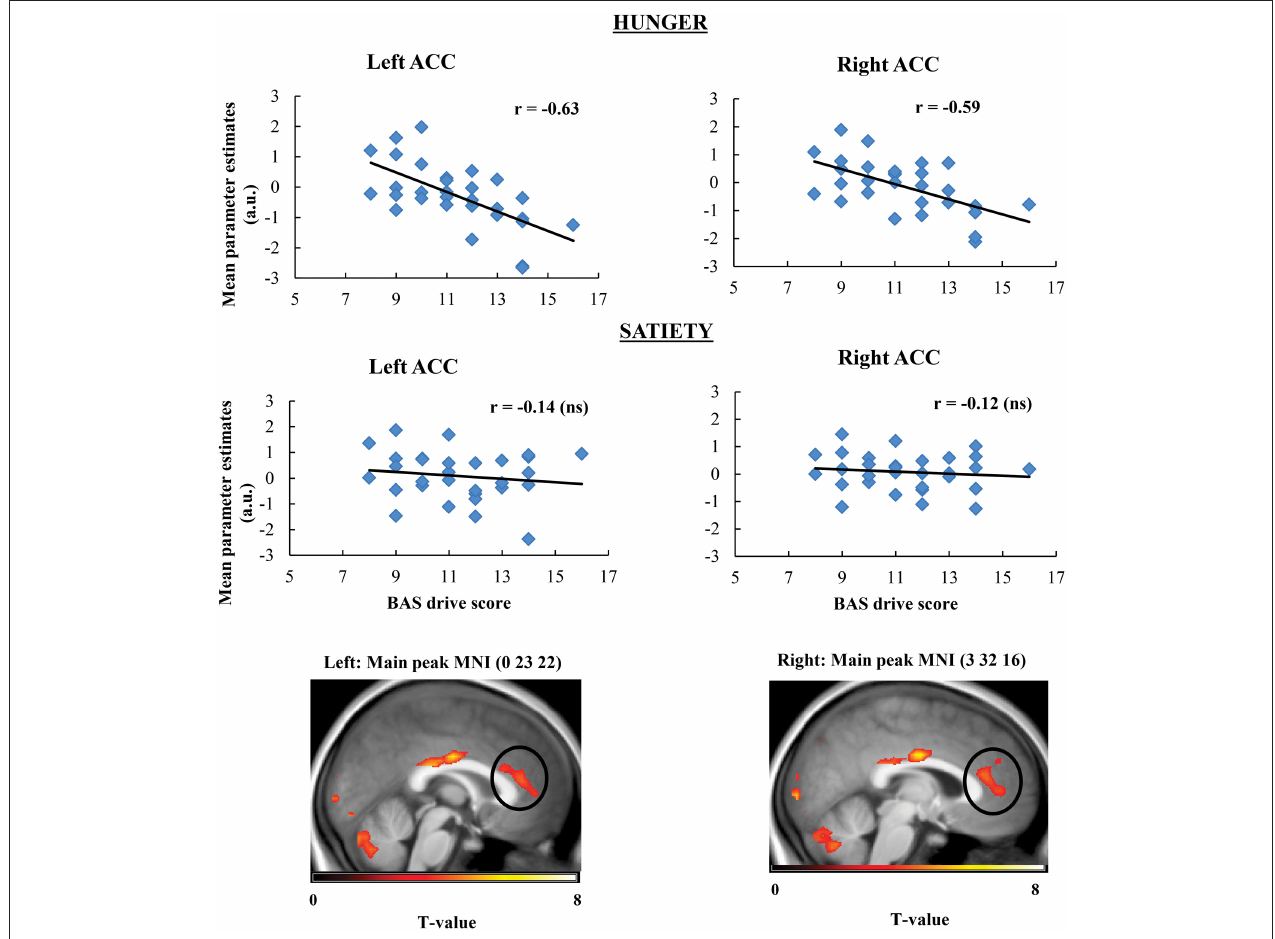
FIGURE 3 | Scatterplot of brain activation in response to oral calories (maltodextrin and sucralose minus sucralose) and reward sensitivity (BAS drive score) during hunger (significant) and satiety (not significant) in the left and right